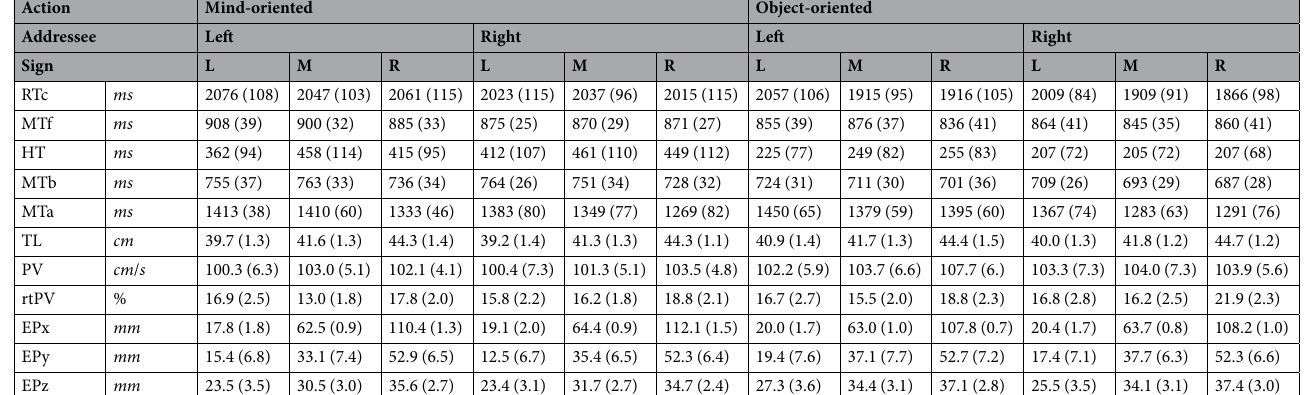
Table 1. Descriptive statistics: mean and standard error of the mean for all conditions. The left, middle and right signs are abbreviated with L, M and R, respectively. RTc = reaction time communicator. MTf = forward